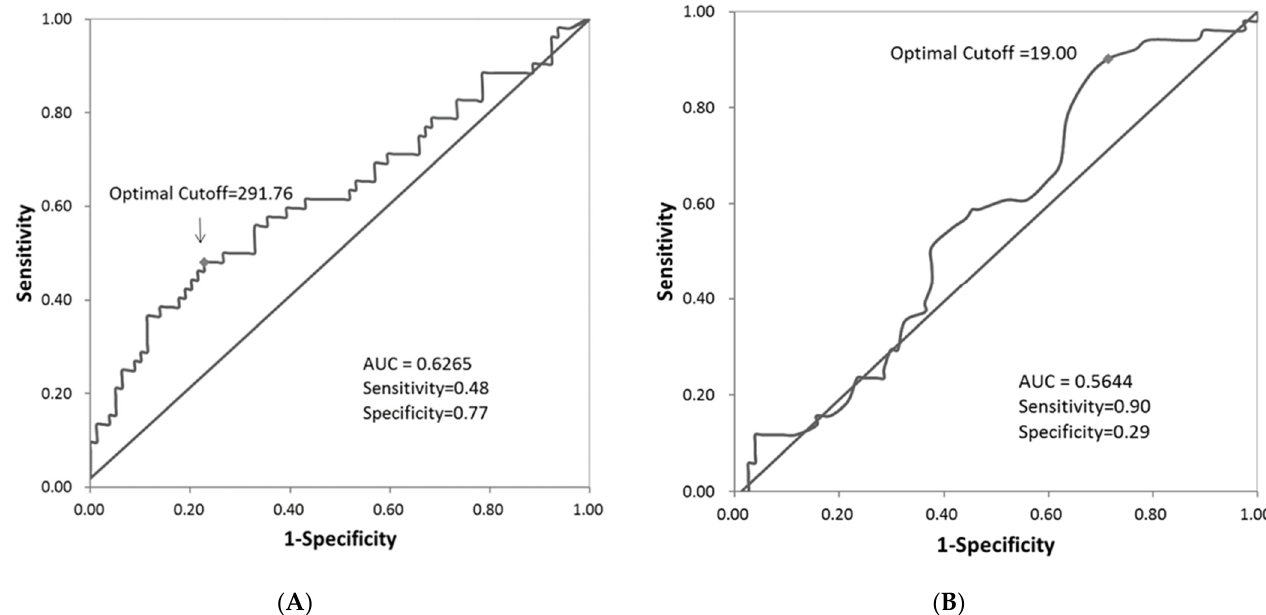
Figure 1. The ROC curves for the optimal cut-off point value for Eosinophils count ( A ) and FeNo measure ( B ). Table 3. The relationships between exacerbation and biomarkers.